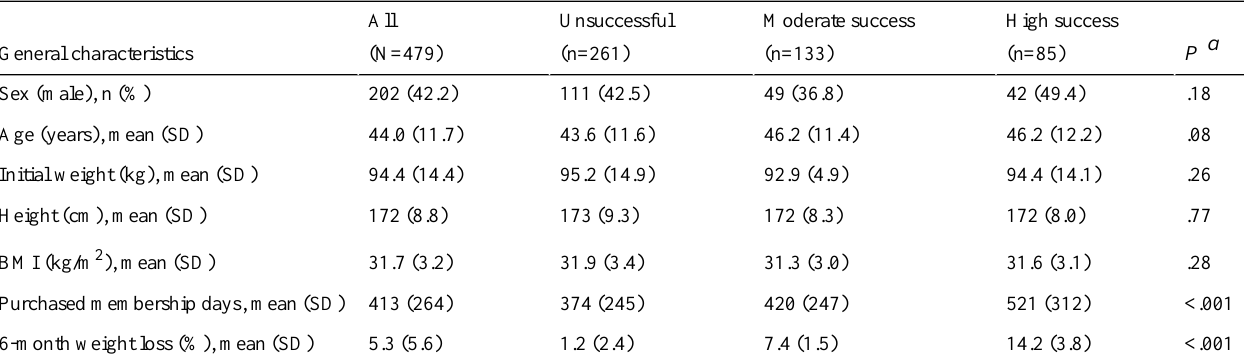
Table 2. General characteristics of the study sample according to the percentage weight loss achieved after 6 months: unsuccessful (lost <5% of